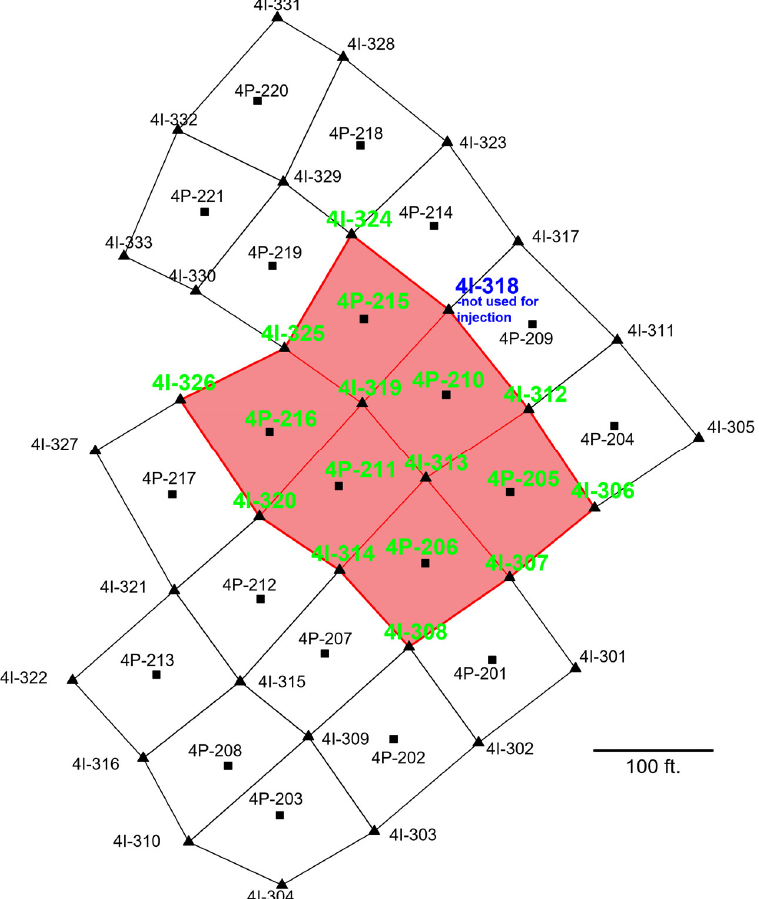
Figure 2. Wells served by HH 4-11, with the well patterns used in the multi-well amendments test shaded pink. The wells designated with a green font were used for the work described here. Note that 4I-318 was not used for these tests because it was plugged.